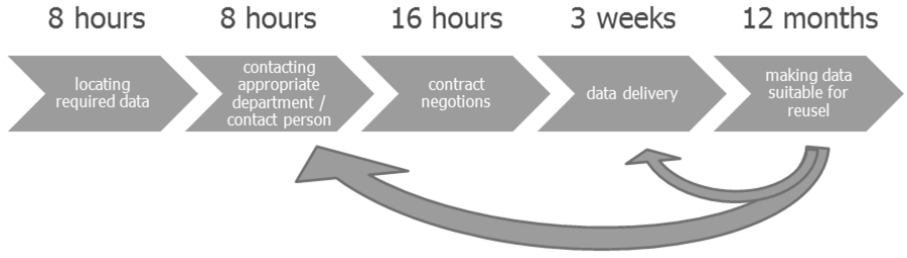
Figure 4. Example of a data supply chain for external users of Liander data prior to open data, expressed in man-hours, including feedback loops and data delivery time.